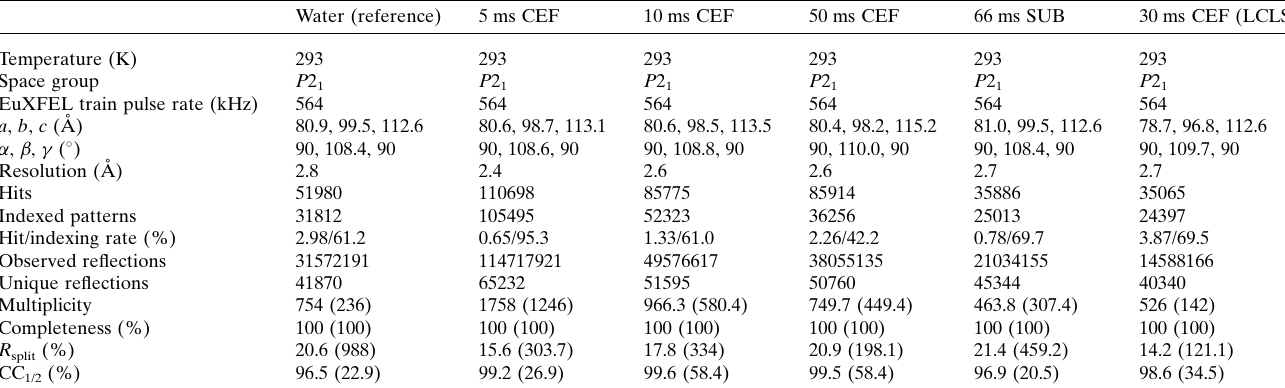
Table 1 Data-collection statistics [30 ms data from Olmos et al.